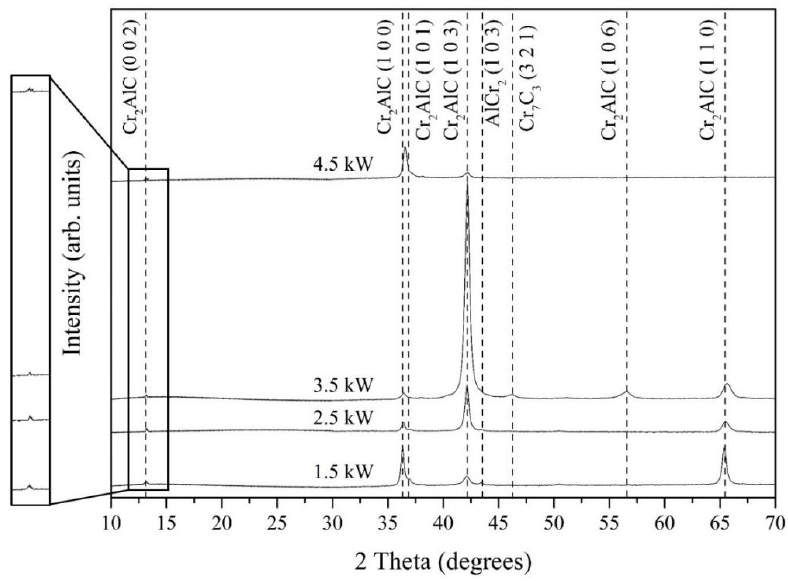
Figure 2. X-ray diffraction (XRD) spectra of Cr 2 AlC coatings deposited at various sputtering power.